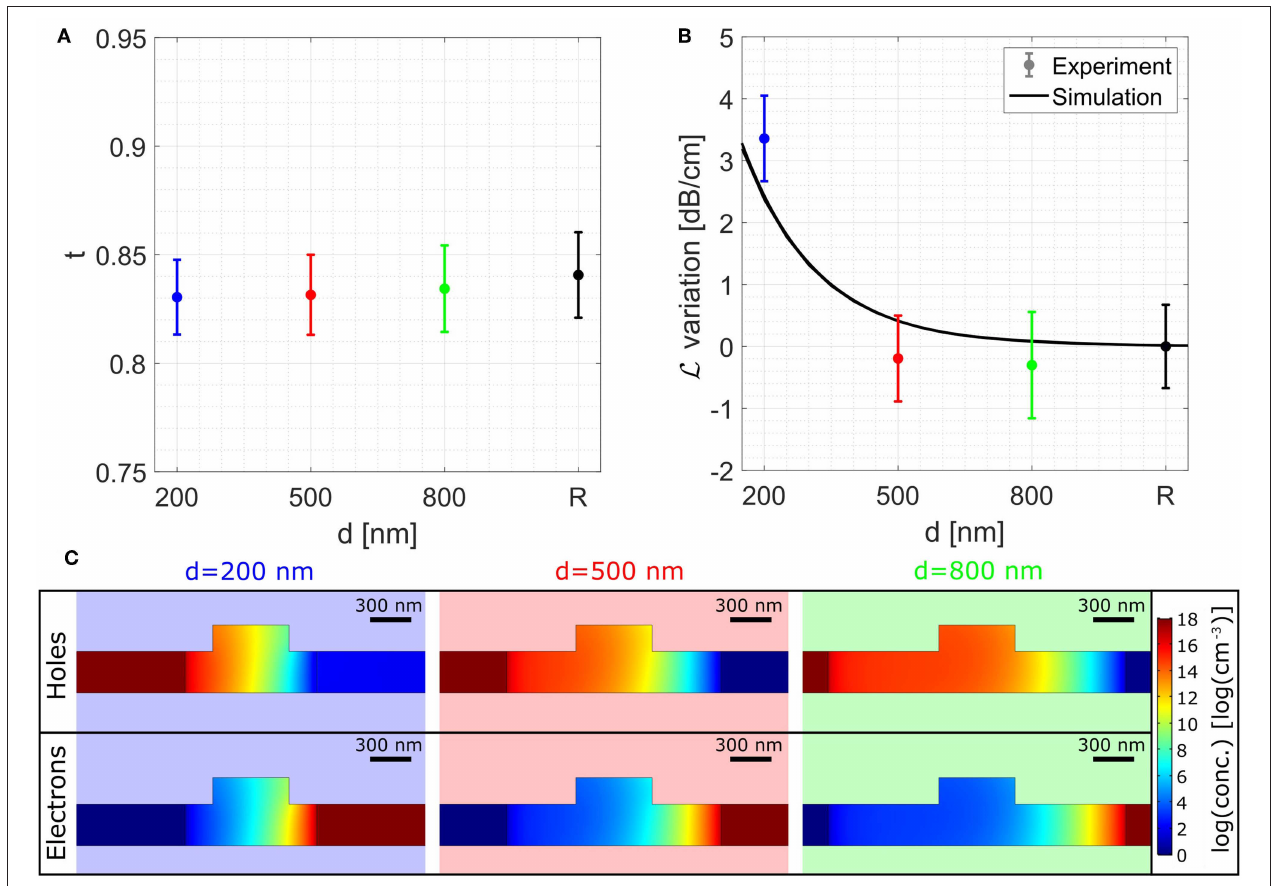
FIGURE 3 | (A) Transmission coefficient t as a function of the distance d between the waveguide border and the doped region. The label by “R” refers to a reference resonator without doped regions. (B) Variation of the loss coefficient L with respect to the reference case. The experimental data are compared with simulations. (C) Electron and hole distribution inside the waveguide for different d